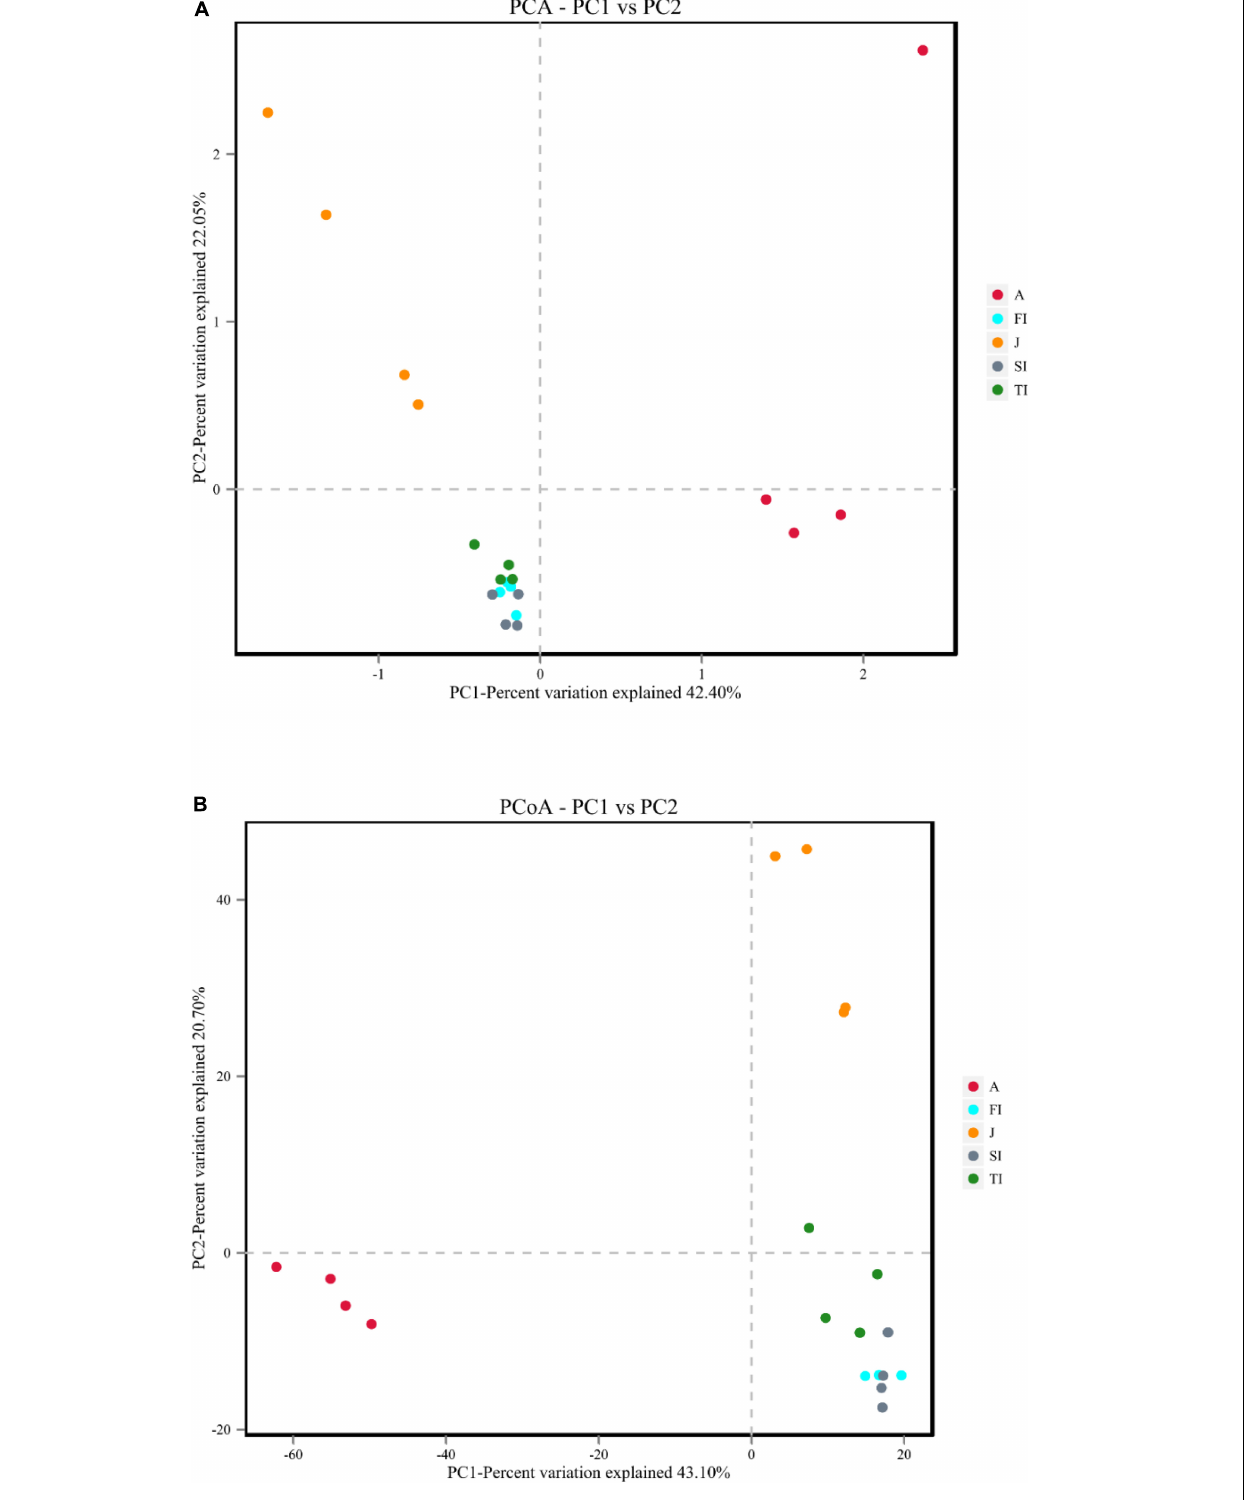
Frontiers in Microbiology |